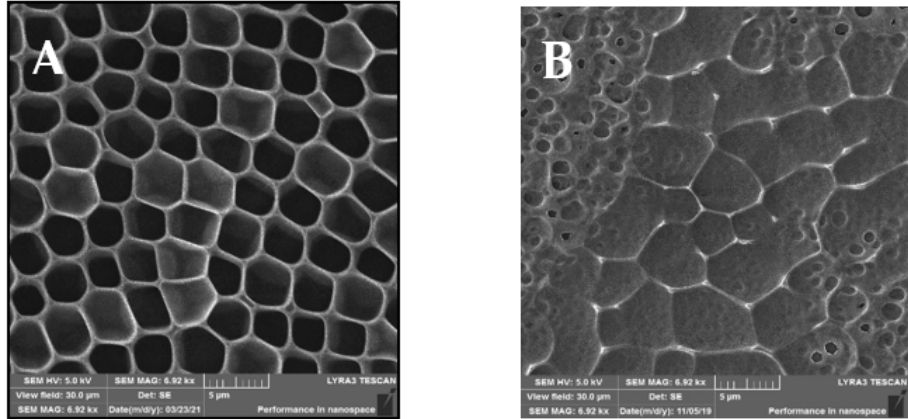
Figure 2. SEM scans of the prepared samples: ( A ) a honeycomb-like (HCP) structure on the plasma- treated fluorinated ethylene propylene (FEP); ( B ) HCP structures with silver nanoparticles sputtered for 150 s. The inspected area was 30 × 30 µm 2 .